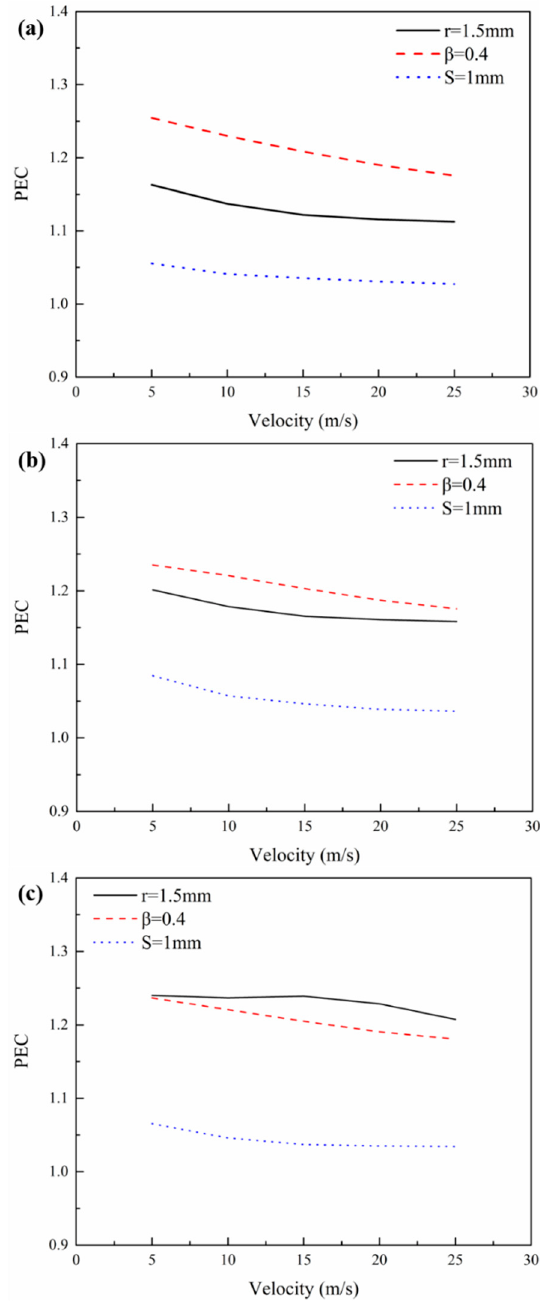
Figure 14. Thermal-hydraulic performance factor versus the inlet velocity for three kinds of wavy fin with ( a ) γ = 0.38; ( b ) γ = 0.42; ( c ) γ = 0.45.